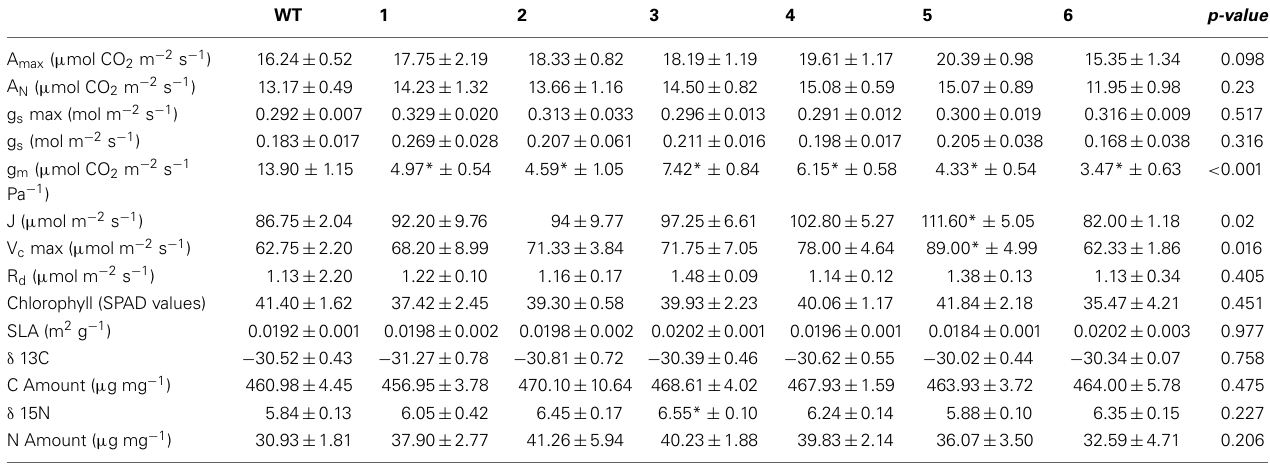
Values are means ± SE. * Statistically significant differences from post-hoc Fisher least significant difference (LSD with α = 0 . 05 ) corrected for the multiple compar- isons. P-value represents result of test for significant differences from ANOVA analysis. Amax, maximum photosynthesis; AN, net photosynthesis; gmax, maximum stomatal conductance; gs, stomatal conductance; gm, mesophyll conductance; J, electron transport rate; Vc max, maximum rate of Rubisco carboxylation; Rd, mitochondrial respiration in the light; SLA, specific leaf area; δ 13C, isotopic composition of carbon; C, carbon; δ 15N, isotopic composition of nitrogen; N, nitrogen.